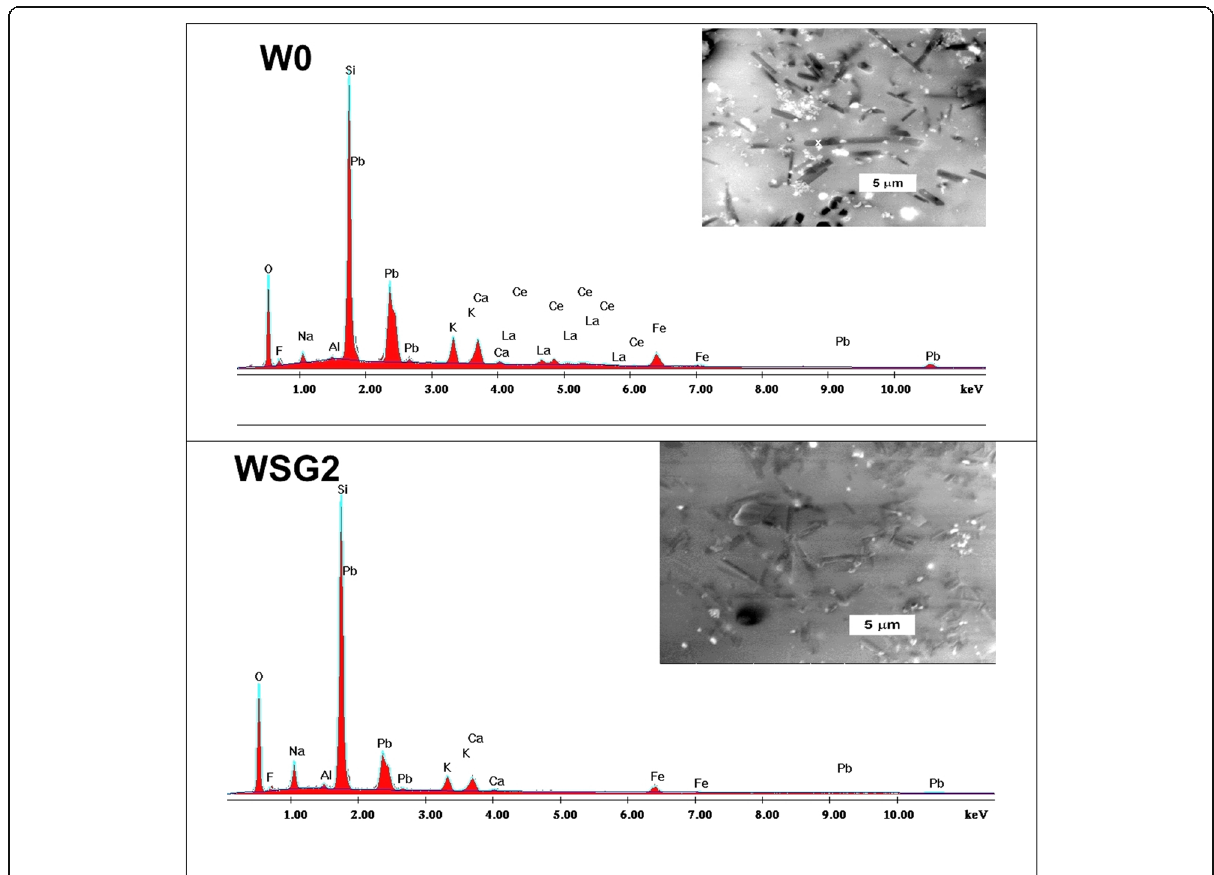
Fig. 4 EDX microanalysis of W0 and WSG2 samples sintered at 900 °C/2 h